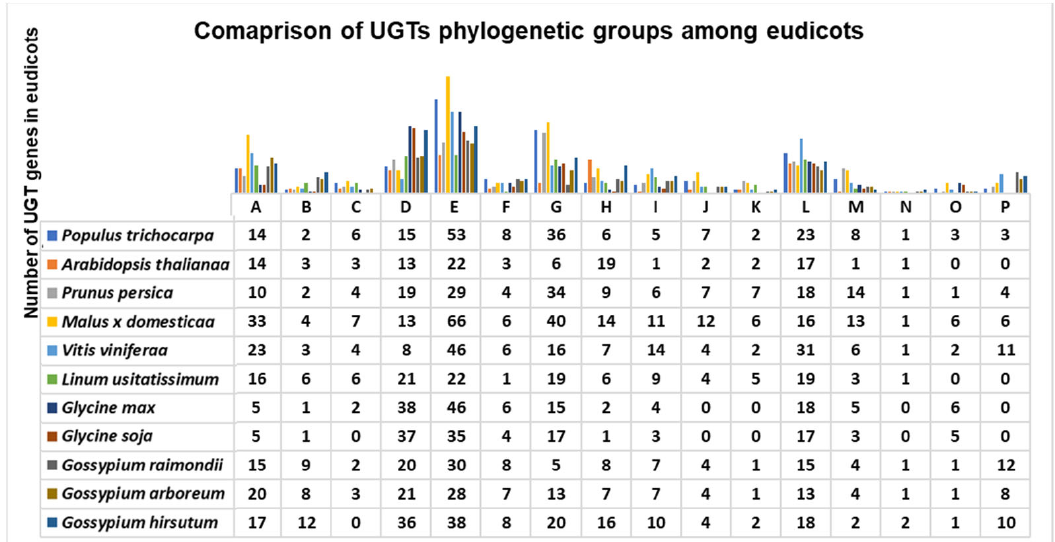
Figure 2. Comparison of Populus UGT phylogenetic groups with those of other published eudi- cots. Sixteen major phylogenetic groups (A–P) can be observed in all putative UGTs from eudicots. Phylogenetic groups such as D, E, G, L and M were expanded in all eudicots while the group N was the most conserved phylogenetic group observed in all eudicots.